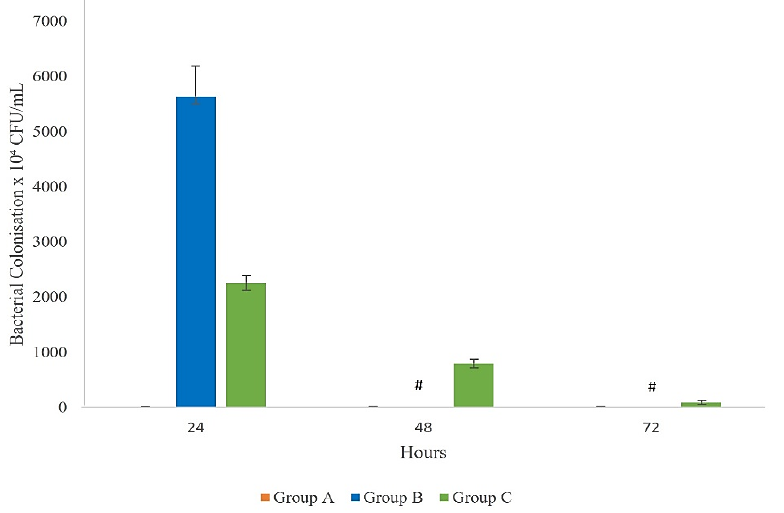
Figure 6. Bacterial colonisation in mice Group A (control group), Group B (unimmunised mice after ETEC challenge), and Group C (immunised mice after ETEC challenge) at 24, 48, and 72 h after lethal ETEC challenge. All the values are mean ± SEM. # = all the mice in Group B died within 24 h; thus, no data were collected at 48 and 72 h in this